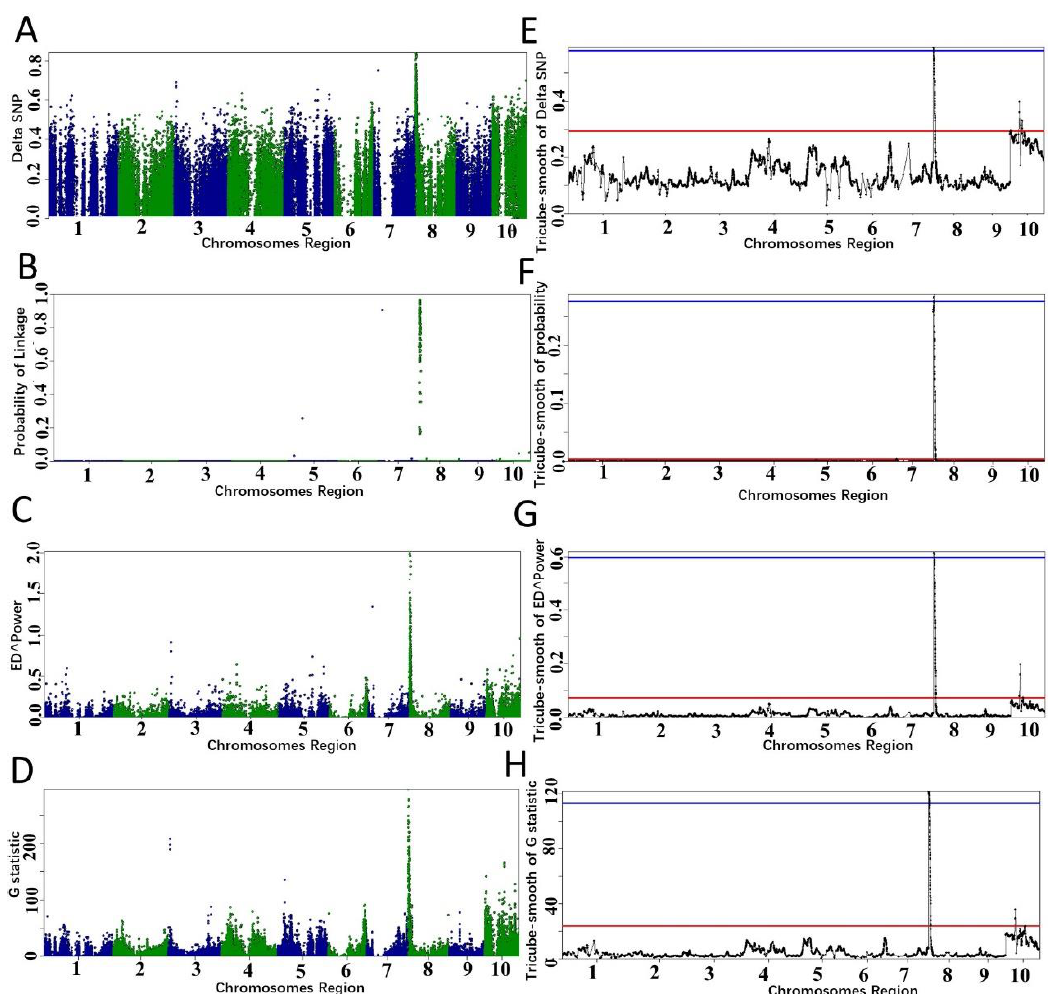
Figure 2. Candidate region identified by different algorithms in PNGseqR for maize small-kernel mutant. The “plot_BSA()” function was used to draw the plot with a 5 Mb sliding window. ( A – D ) The scatter plots were exported from the BSA results, and the algorithms were ΔSNP, empirical Bayes, ED, and G-test, respectively. ( E – H ) The tricube-smoothed values of the corresponding statistics. The red line is the threshold set by the >99.5% quantile, and the blue line is the threshold set by p -values < 0.001. Table 1. The candidate region for maize small-kernel mutant identified by PNGseqR.